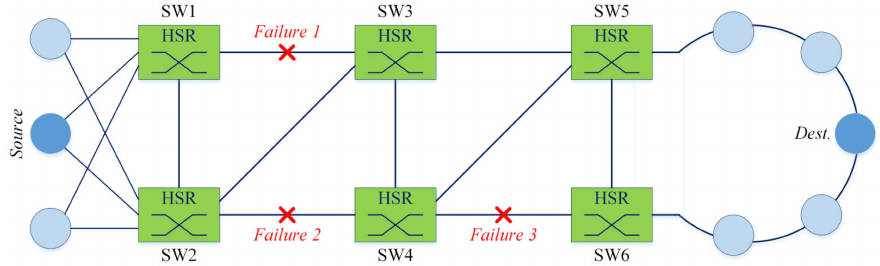
Figure 23. The network in Simulation